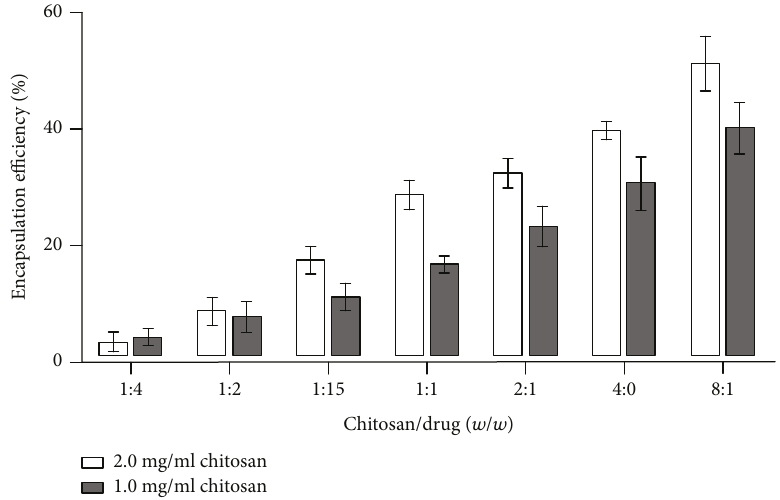
Figure 1: E ff ect of the mass ratio of chitosan to Alphastatin on Alphastatin encapsulation e ffi ciency (%). Table 1: E ff ect of the mass ratio of chitosan to Alphastatin on nanoparticle size and zeta potential. Chitosan concentration is 2 mg/ml. Mass ratio of chitosan to Alphastatin